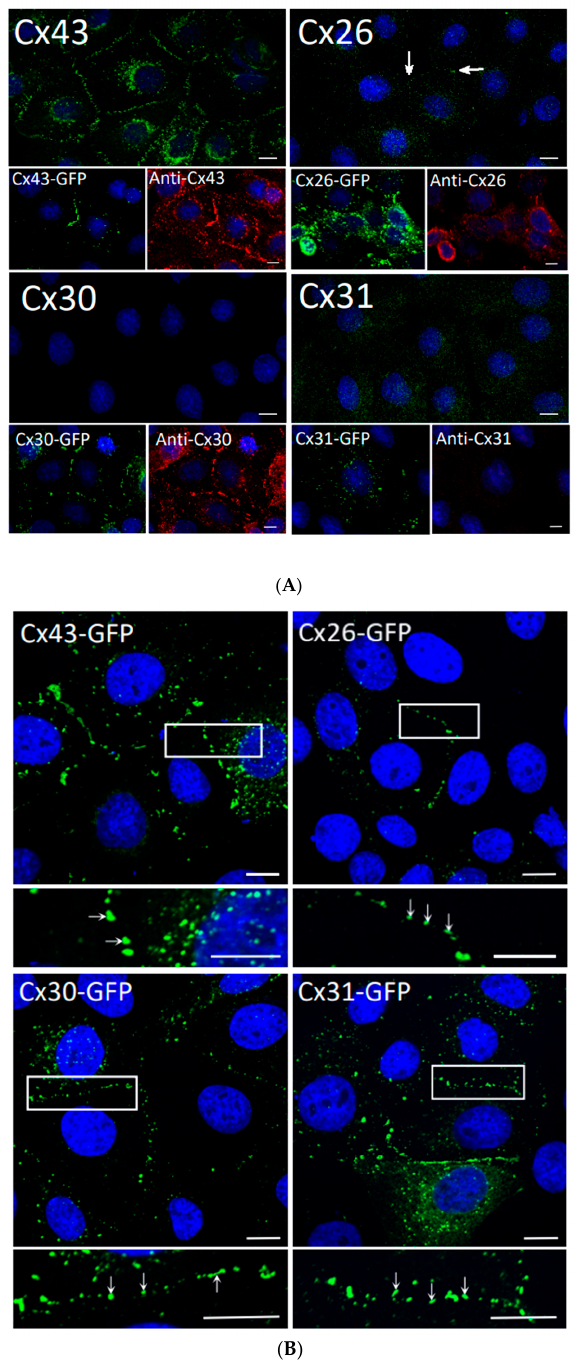
Figure 2. Rat epidermal keratinocytes (REKs) express endogenous Cx43 and retain the capacity to assemble GFP-tagged Cx26, Cx30 and Cx31 into gap junctions. ( A ) Basal keratinocyte-like REKs express endogenous Cx43, trace amounts of Cx26 (arrows) but no detectable levels of Cx30 or Cx31 protein. REKs engineered to express GFP-tagged connexins were used to demonstrate that the anti-connexin antibodies were efficient at detecting connexins with the exception of the anti-Cx31 antibody. ( B ) REKs engineered to express GFP-tagged Cx43, Cx26, Cx30 and Cx31 all assembled prototypical gap junctions characterized by small punctate structures at sites of cell-cell interface (arrows). In addition, an array of intracellular fluorescent structures could be identified that reflect organelles and vesicles involved in connexin transport. Nuclei were stained with Hoechst dye. Bars = 10 μ m.